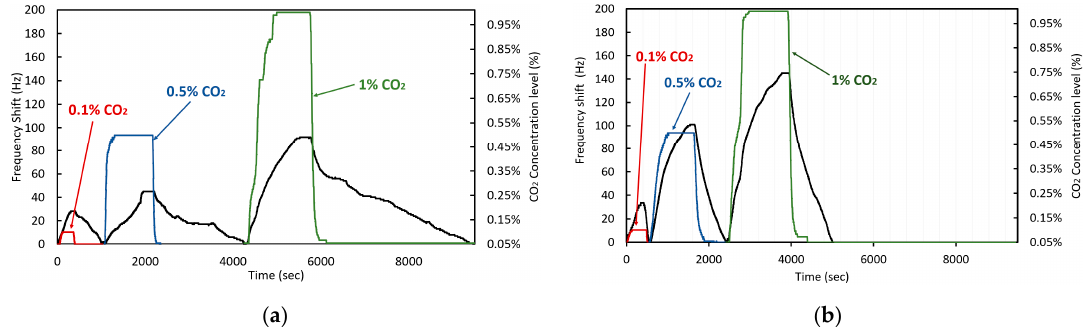
Figure 10. Quartz crystal frequency shift in response to different CO 2 concentration cycles for ( a ) branched PEI coated crystal, and ( b ) linear PEI coated crystal.